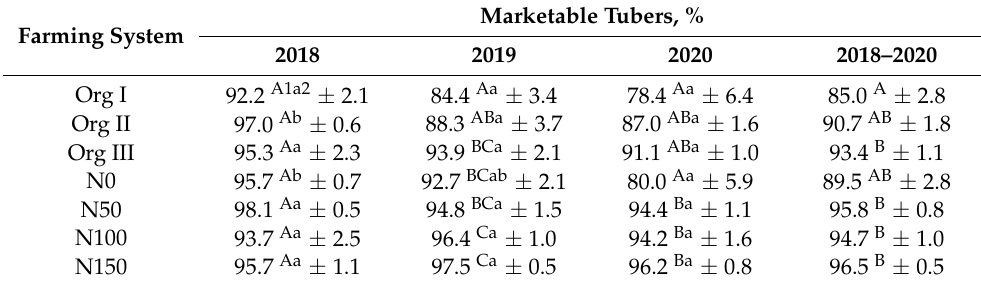
Table 4. Average share of marketable potato tubers depending on the farming system. Farming System